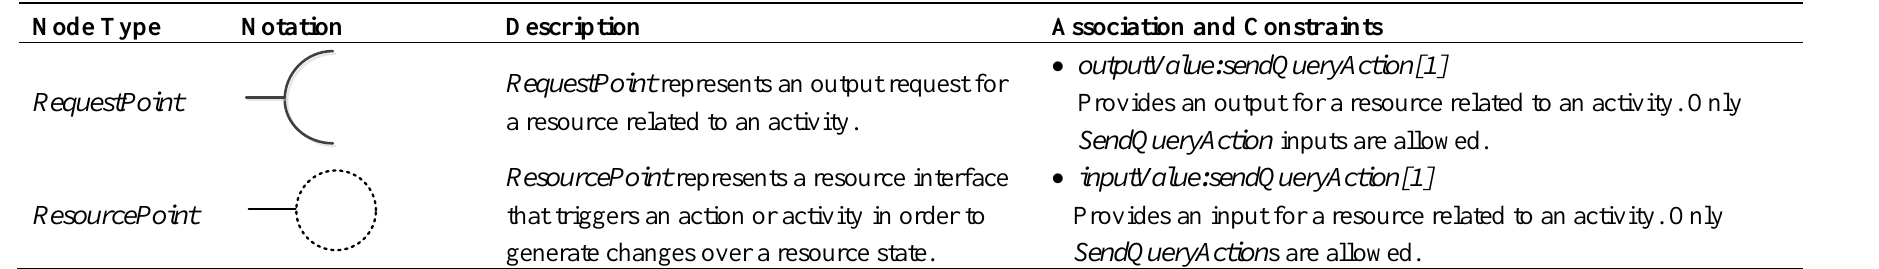
Table 3. Graphic paths included in SsML